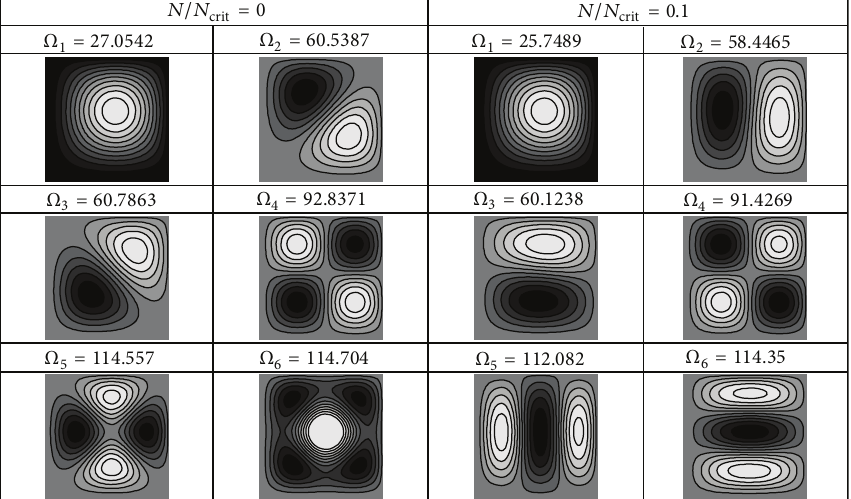
Figure 3: Normal modes of vibration of a square C-C-SS-SS plate under uniform 𝑁 𝑥 loading ( 𝜆 = 𝑎/𝑏 = 1 , 𝑁